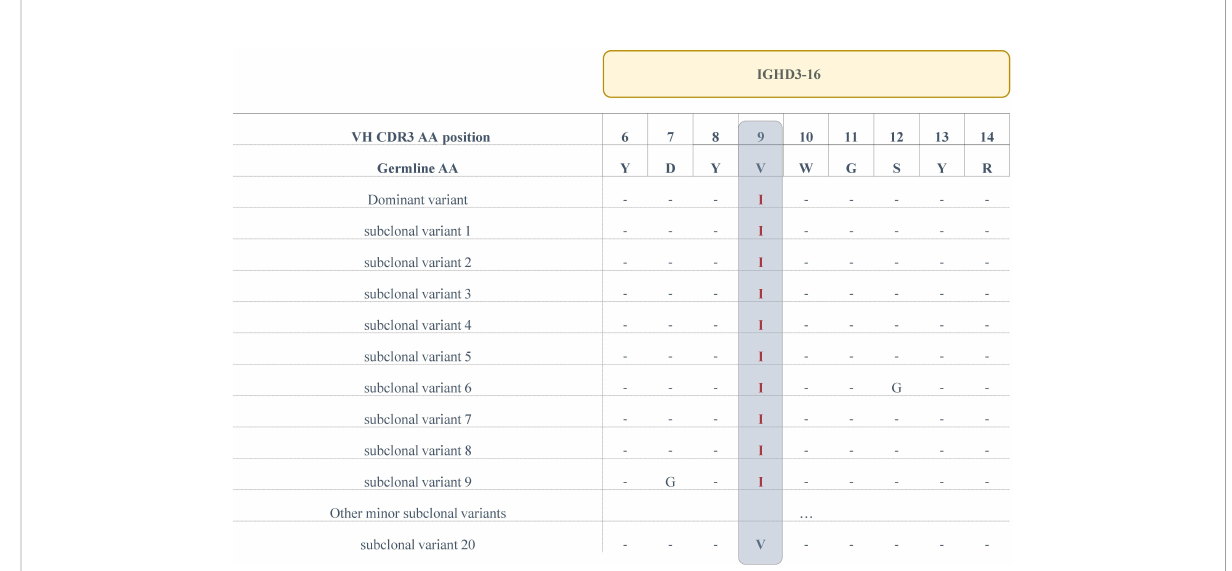
FIGURE 3 Alignment of the IGHD3-16-encoded region of the VH CDR3 of the main clonotype and subclonal variants for patient H73. The sequences of all variants (at the amino acid level) that display a V>I aa substitution at position 9 are depicted, as well as a single subclonal variant bearing the germline IGHD3-16-encoded Valine at the same